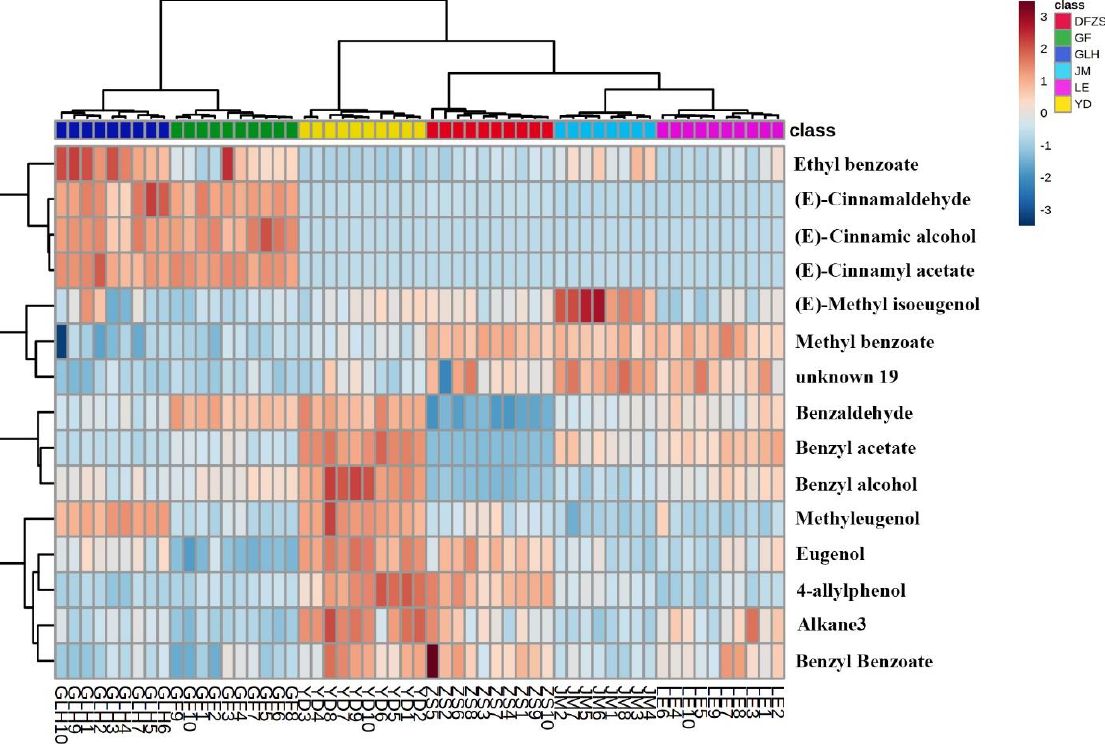
Figure 3. HCA analyses of fifteen differential volatile compounds of six varieties of P. mume blossom samples.